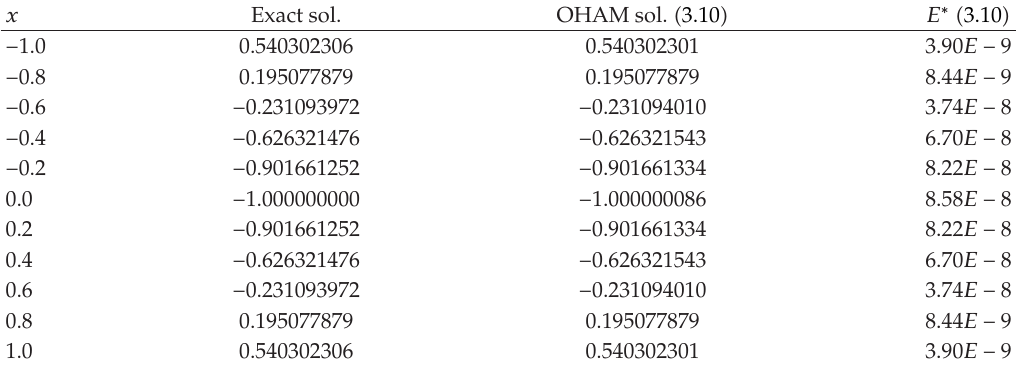
Table 2: The maximum absolute error as reported in (cid:7) 28 (cid:8) is 1 . 8775 × 10 − 5 , while in our case, it is 8 . 5757 × 10 − 8 . x Exact